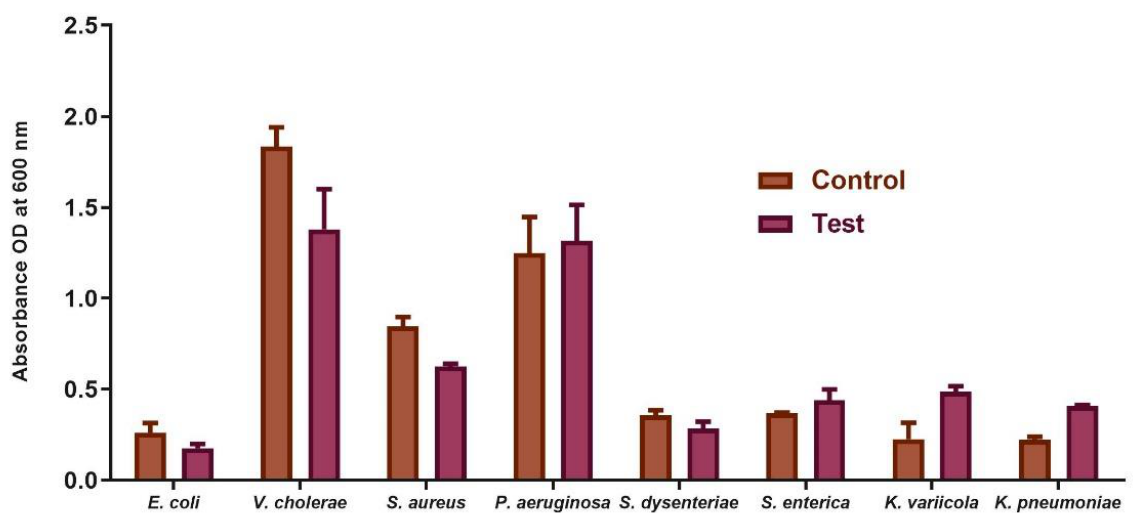
Figure 3. Effect of ACF on biofilm formation. All organisms grown in LB broth (0.4 OD) treated with ACF at 1:1 ratio is the test and the cultures without ACF served as a control. The absorbance was measured at OD 600 nm after crystal violet staining. Values are means ± standard deviation of three replicates.